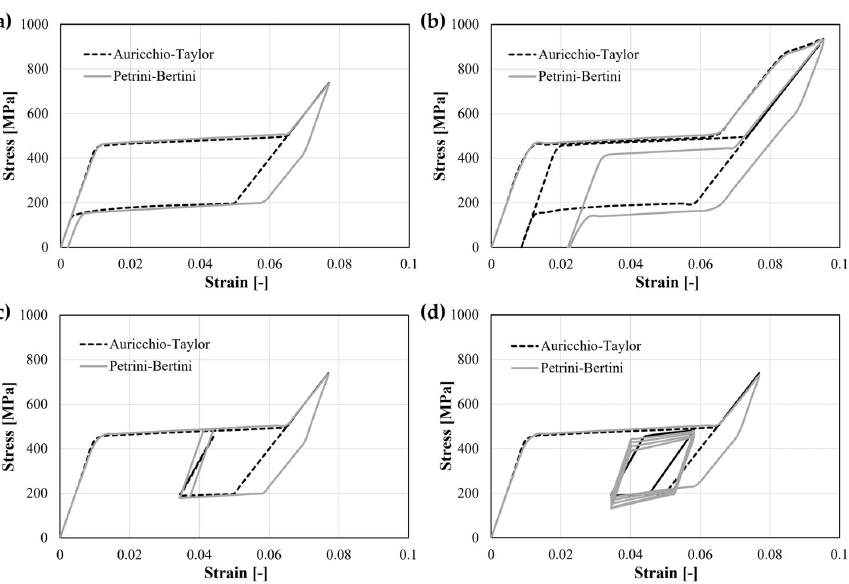
Figure 5. Comparison between the results of two different constitutive models formulated for describing Ni-Ti alloy behavior. ( a ) Superelastic loading and unloading; ( b ) superelastic–plastic loading, followed by total unloading, showing residual strain, and a second loading phase; ( c ) superelastic loading and partial unloading, followed by fatigue cycles with low amplitude strains; ( d ) superelastic loading and partial unloading, followed by fatigue cycles with higher amplitude strains, where it is possible to appreciate the different behavior related to the inelastic strain